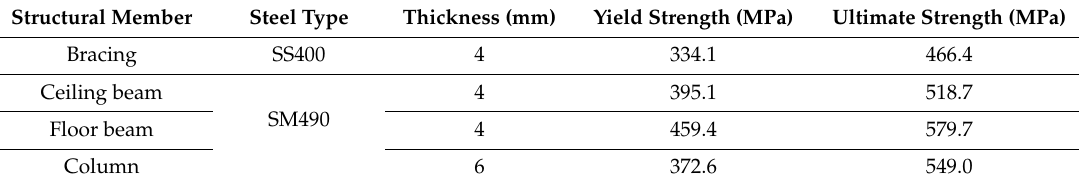
Table 3. Material properties of blind